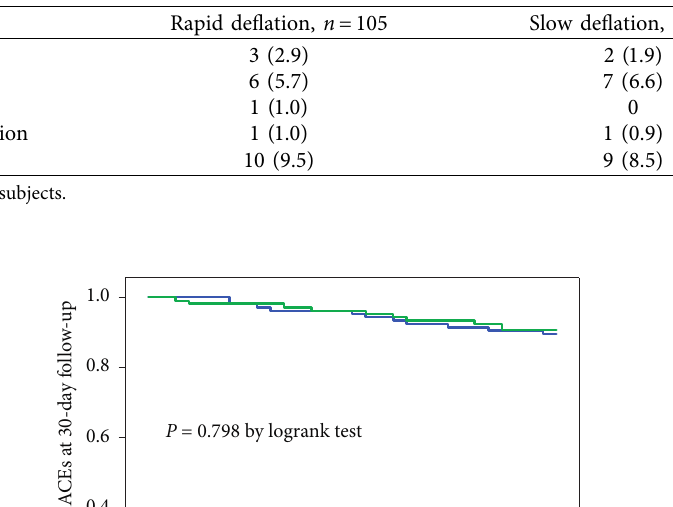
Table 5: MACEs at 30-day.